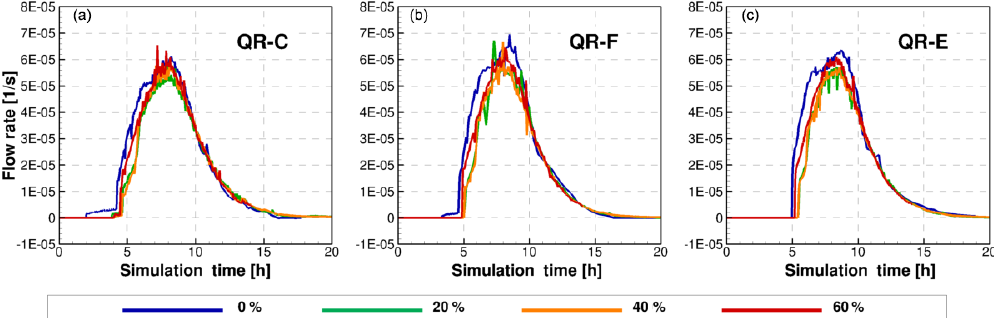
Figure 8. Normalized hydrographs at the gauged points downstream of the confluence. In panel (a) we depict the point closest to the confluence, in panel (b) the flooding zone, and in panel (c) the outlet of the computational domain.